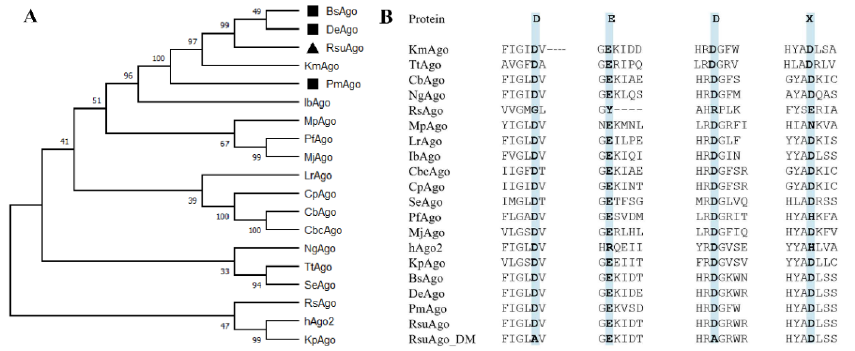
Figure 1. Sequence analysis and phylogenetic tree visualizations. ( A ) Maximum-likelihood phyloge- netic tree analysis of RsuAgo based on amino acid sequences. The numbers at the nodes indicate the bootstrap values for the maximum likelihood analysis of 1000 resampled data sets. RsuAgo is indi- cated as a black triangle, BsAgo, DeAgo, and PmAgo are indicated as a black rectangle. ( B ) Multiple sequence alignment of RsuAgo, DeAgo, BsAgo, and PmAgo with several other characterized pAgo proteins. The catalytically dead variant of the RsuAgo protein (RsuAgo_DM) with amino acid substitutions in the catalytic tetrad is